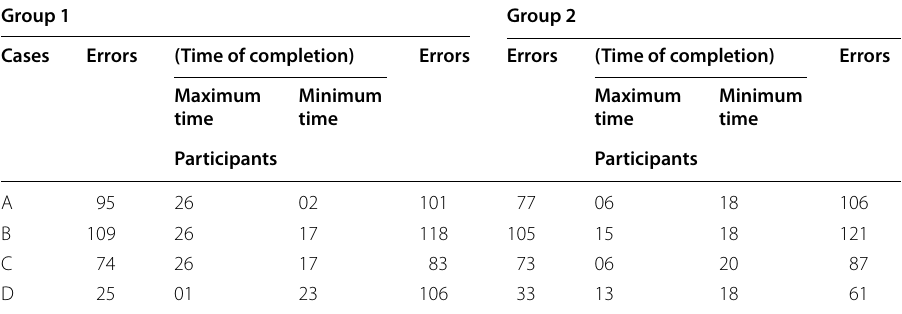
Table 5 The relationship between transcription time (maximum and minimum time) and total number of errors committed by participants Group 1 Group 2